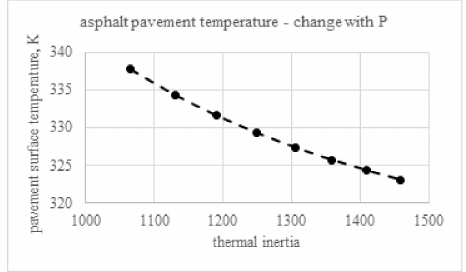
Figure 10. Asphalt pavement surface temperatures with changing thermal inertia values.